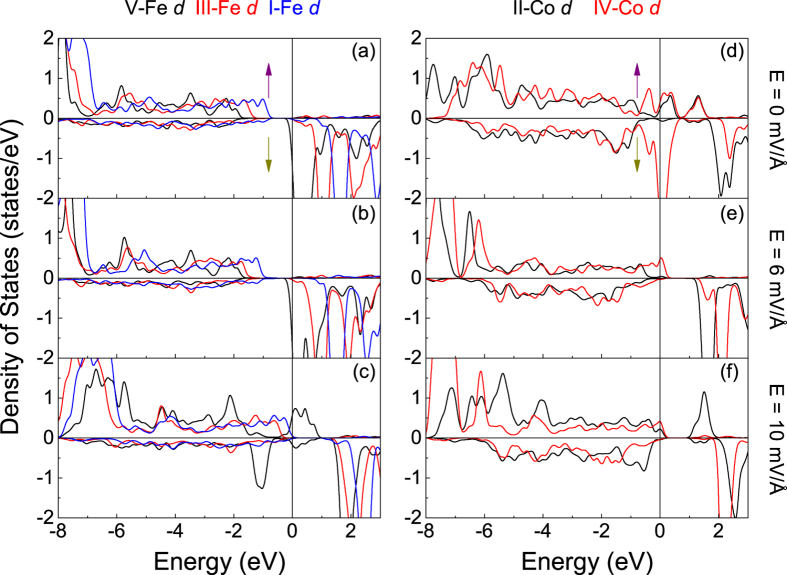
Partial DOS for (a–c) Fe and (d–f) Co in each layer of model BiO-FeO2 on different values of electric field. EF = 0 eV.